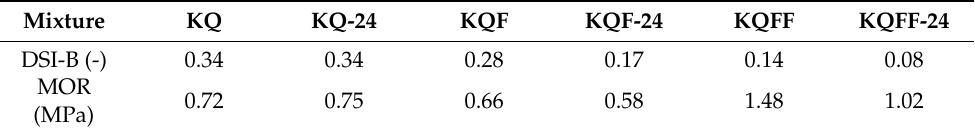
Table 5. Drying Sensitivity Index, according to Bigot (DSI-B), and Modulus of Rupture (MOR) of dried test samples depending on the fly ash content and 24 h ageing (KQ-24, KQF-24, KQFF-24). Mixture KQ